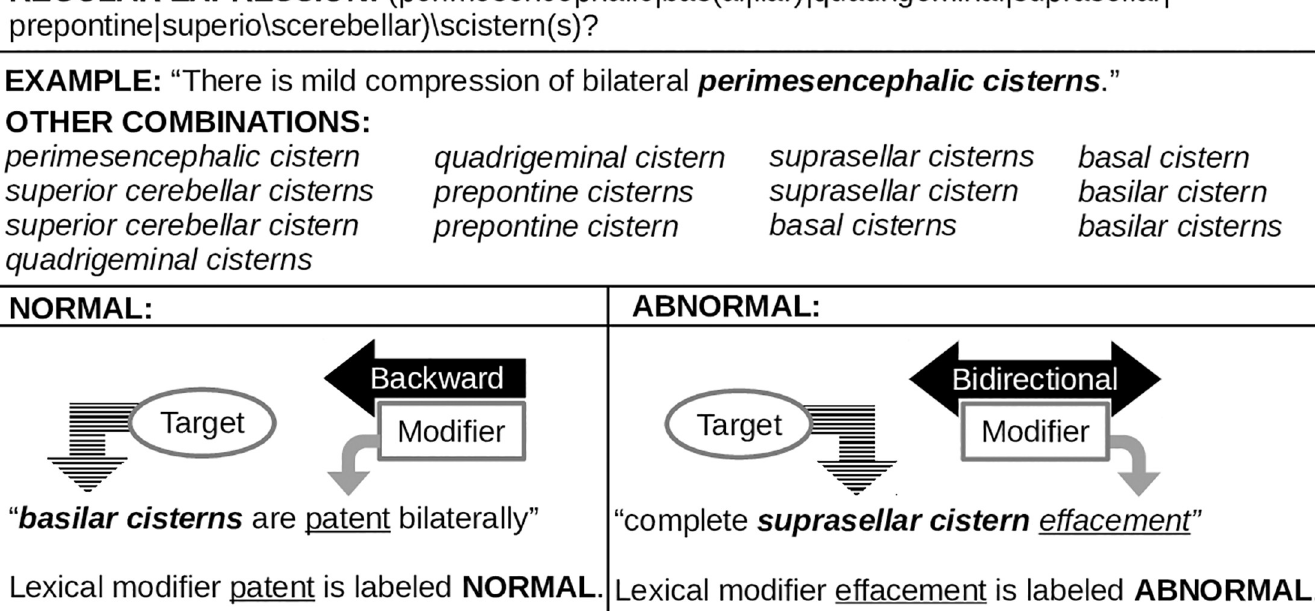
Fig 2. First example of the application of lexical targets and lexical